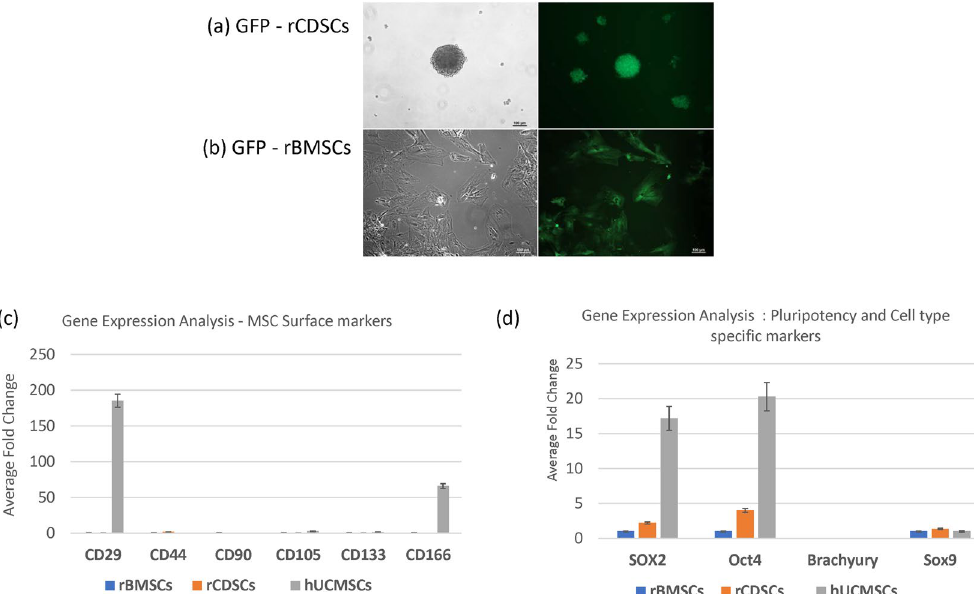
Figure 1. Panel represents a photomicrograph of ( a ) rCDSCs spheroids; ( b ) rBMSCs in adherent flasks in cell culture under bright field and green fluorescence setting using Nikon microscope (Nikon Eclipse TE2000-U, Scale bar: 100 µm). Total RNA was isolated from rCDSCs, rBMSCs and hUCMSCs and gene expression was determined using qPCR analysis. Histograms show expression level of ( c ) MSC surface markers (CD29, CD44,